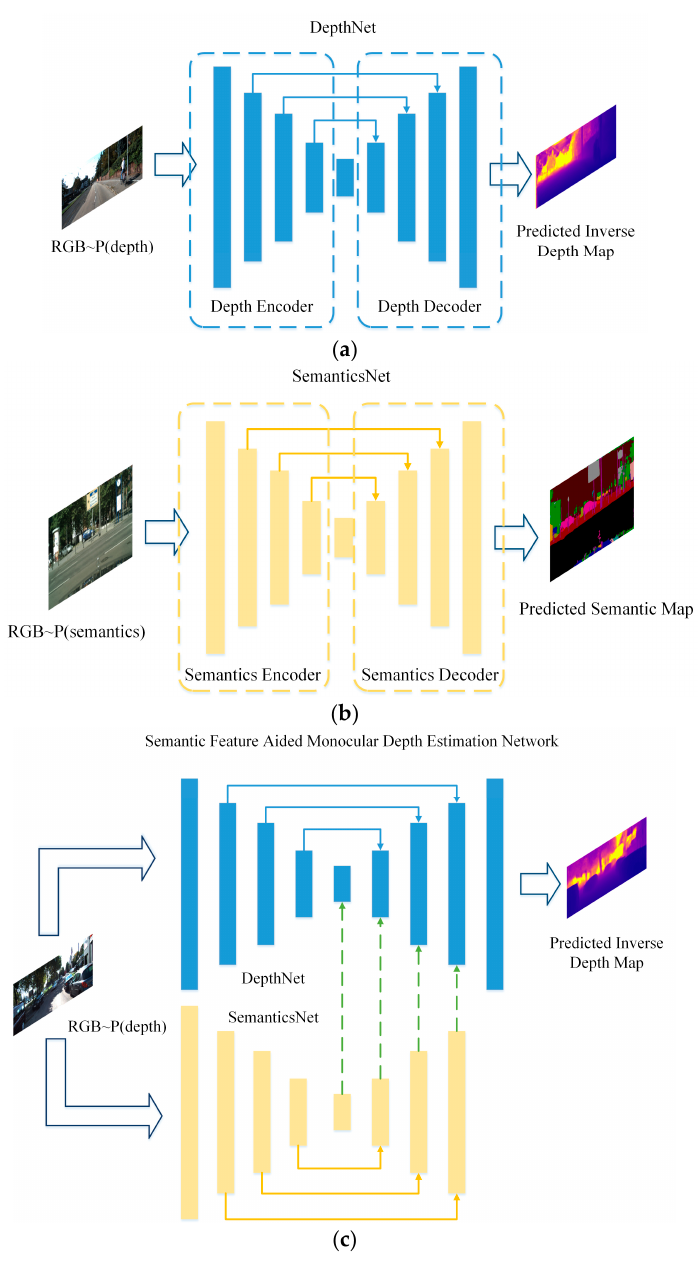
Figure 1. Overview of SFA-MDEN. The symbol RGB~P(depth) means that the input RGB image is required to have depth annotations for training. Similarly, RGB~P(semantics) means the requirement of semantics labels. ( a ) DepthNet: an unsupervised network to predict depth map as the main branch of SFA-MDEN, ( b ) SemanticsNet: a network for semantic segmentation to generate multi-resolution semantic feature maps for SFA-MDEN, ( c ) The overall framework of SFA-MDEN Based on the TSTB training strategy, our SFA-MDEN has achieved monocular depth estimation based on the stereo sets of KITTI and semantic corpus of